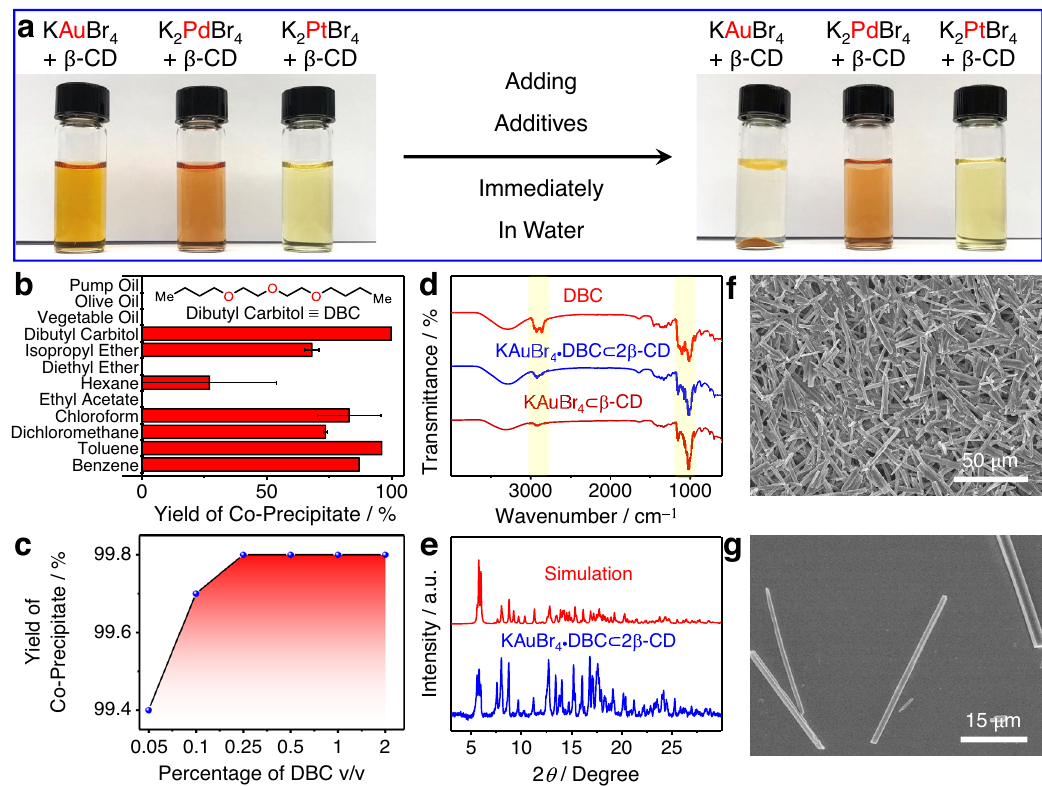
Fig. 2 | Additive-induced supramolecular polymerization between β -CD, KAuBr 4 , and a collection of additives. a Visual display of the selective co- precipitation between β -CD and KAuBr 4 upon adding additives. b Effect of adding different additives on the yield of gold-bearing co-precipitates. The error bar represents the standard deviation of two independent measurements. c Effect of the amount of dibutyl carbitol (DBC) on the yield of gold-bearing co-precipitates. d FTIR Spectra of DBC, KAuBr 4 ⊂ β -CD, and the KAuBr 4 ·DBC ⊂ 2 β -CD co-precipitate